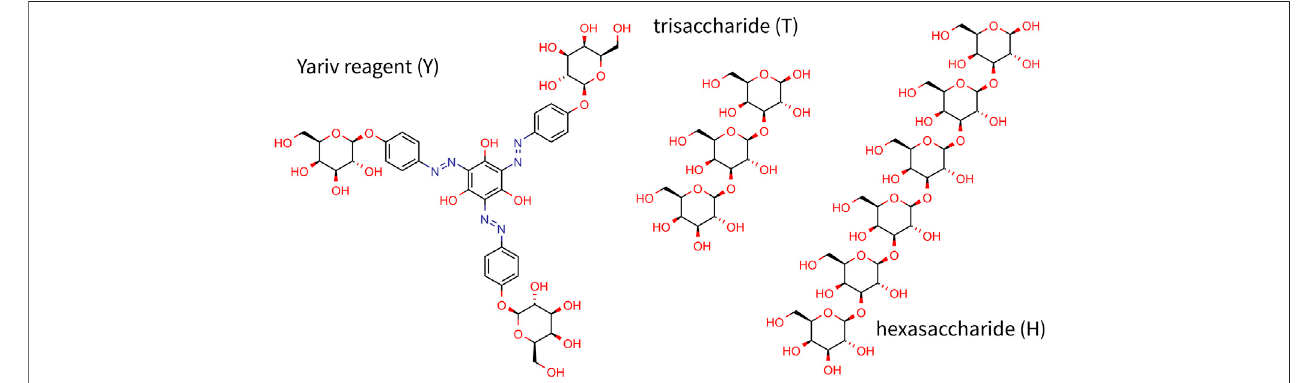
FIGURE 1 | Chemical structure of Yariv reagent and oligosaccharides studied in this